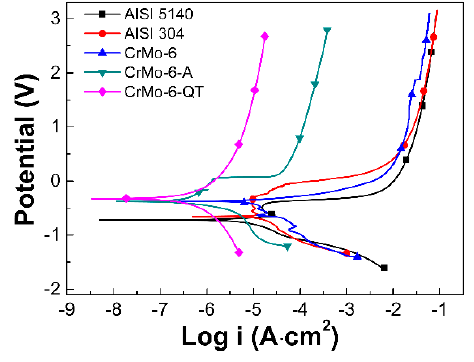
Figure 8. Polarization curves of different samples. Table 2. Corrosion parameters of different samples in a 3.5% NaCl aqueous solution.